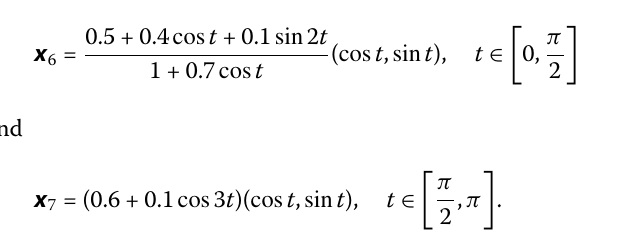
The curve Γ is chosen as the combination of 0.5 + 0.4 cos t + 0.1 sin 2 x 6 =